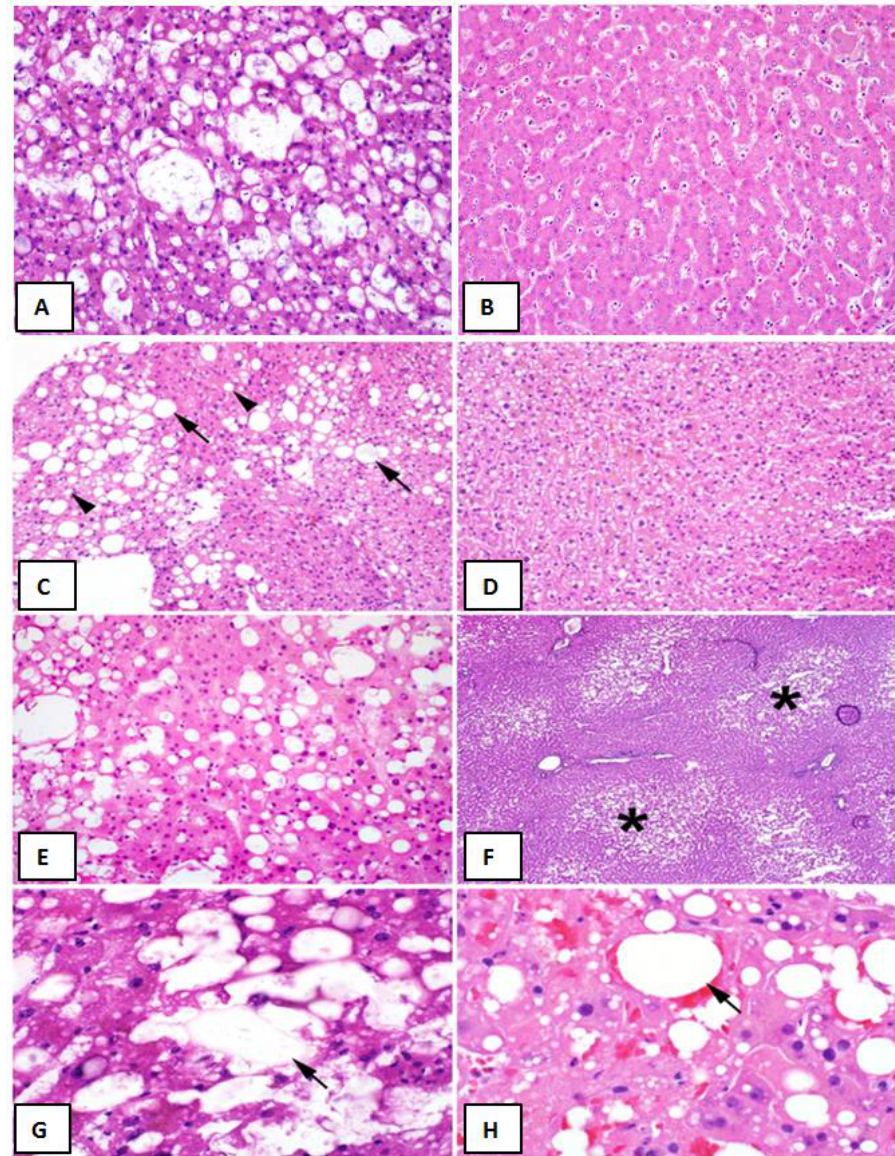
Figure 1. Liver Graft Biopsy Findings Liver Biopsy Findings. ( A ) Representative biopsy of a > 30% macrovesicular steatotic allograft. ( B ) Representative biopsy of a non-steatotic allograft. ( C ) Approximately 30% macrovesicular steatosis with a mixture of large (arrows) and small (arrowheads) droplet fat (hematoxylin and eosin (H&E), 200×). ( D ) Microvesicular steatosis characterized by diffuse deposition of fat droplets in the hepatocyte cytoplasm without any macrovesicular steatosis (H&E, 200×). ( E ) Approximately 40% macrovesicular steatosis seen on a pre-implantation biopsy (H&E frozen section, 400×). ( F ) Zonal distribution of macrovesicular steatosis with fat deposition accentuated in zone three (asterisks) around the central veins (H&E, frozen section, 100×). ( G ), Lipopeliosis characterized by the rupture of hepatocytes with coalescence of fat droplets (arrow) in the sinusoidal spaces (H&E, frozen section, 600×). ( H ), Lipopeliosis (arrow) in post-reperfusion biopsy (H&E, 600×).